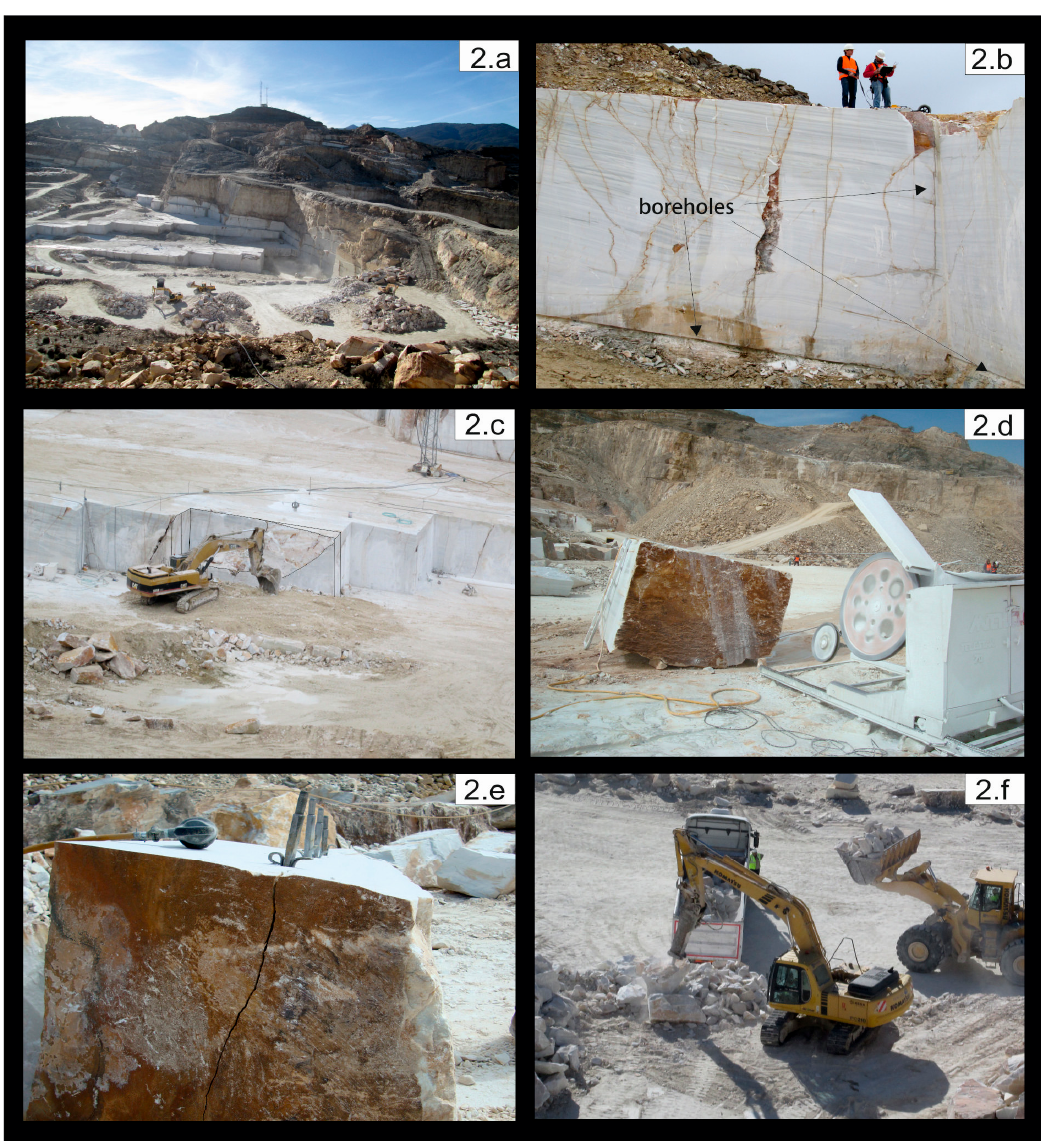
Figure 2. ( a ) Overview of the quarry; ( b ) Details of the three perpendicular holes that delineate the secondary bank; ( c ) Cutting of tertiary blocks with a diamond wire (detail of the block is outlined). Excavator extracting blocks over the sand bed. Note the breakage along a fracture plane; ( d ) Squaring a block with a diamond wire; ( e ) Squaring a block with a drill and wedges along a crack; ( f ) Excavator with a hydraulic hammer reducing the size of the stone intended for micronized carbonate.